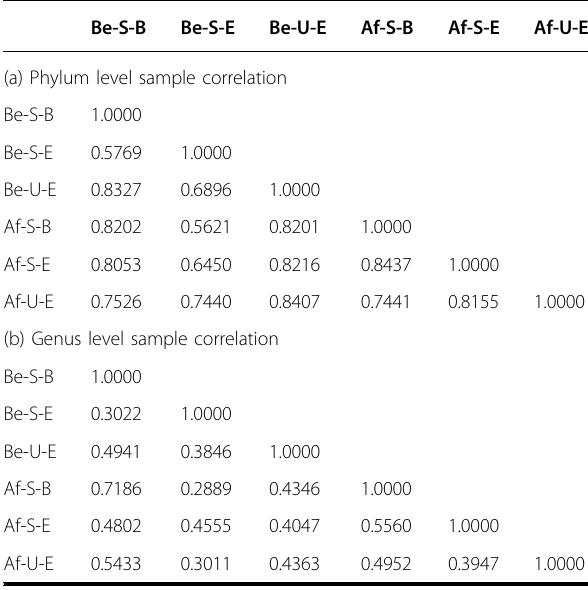
Table 2 Correlation between the microbiota composition of sample types before and after synbiotic beverage consumption at the a) phylum and b) genus